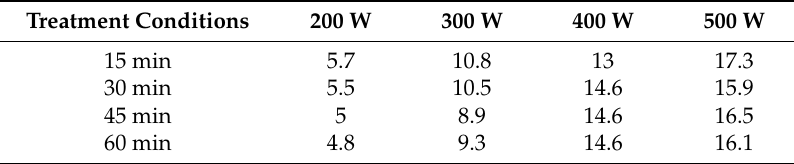
Table 2. The final temperature of samples after different ultrasound treatment ( ◦